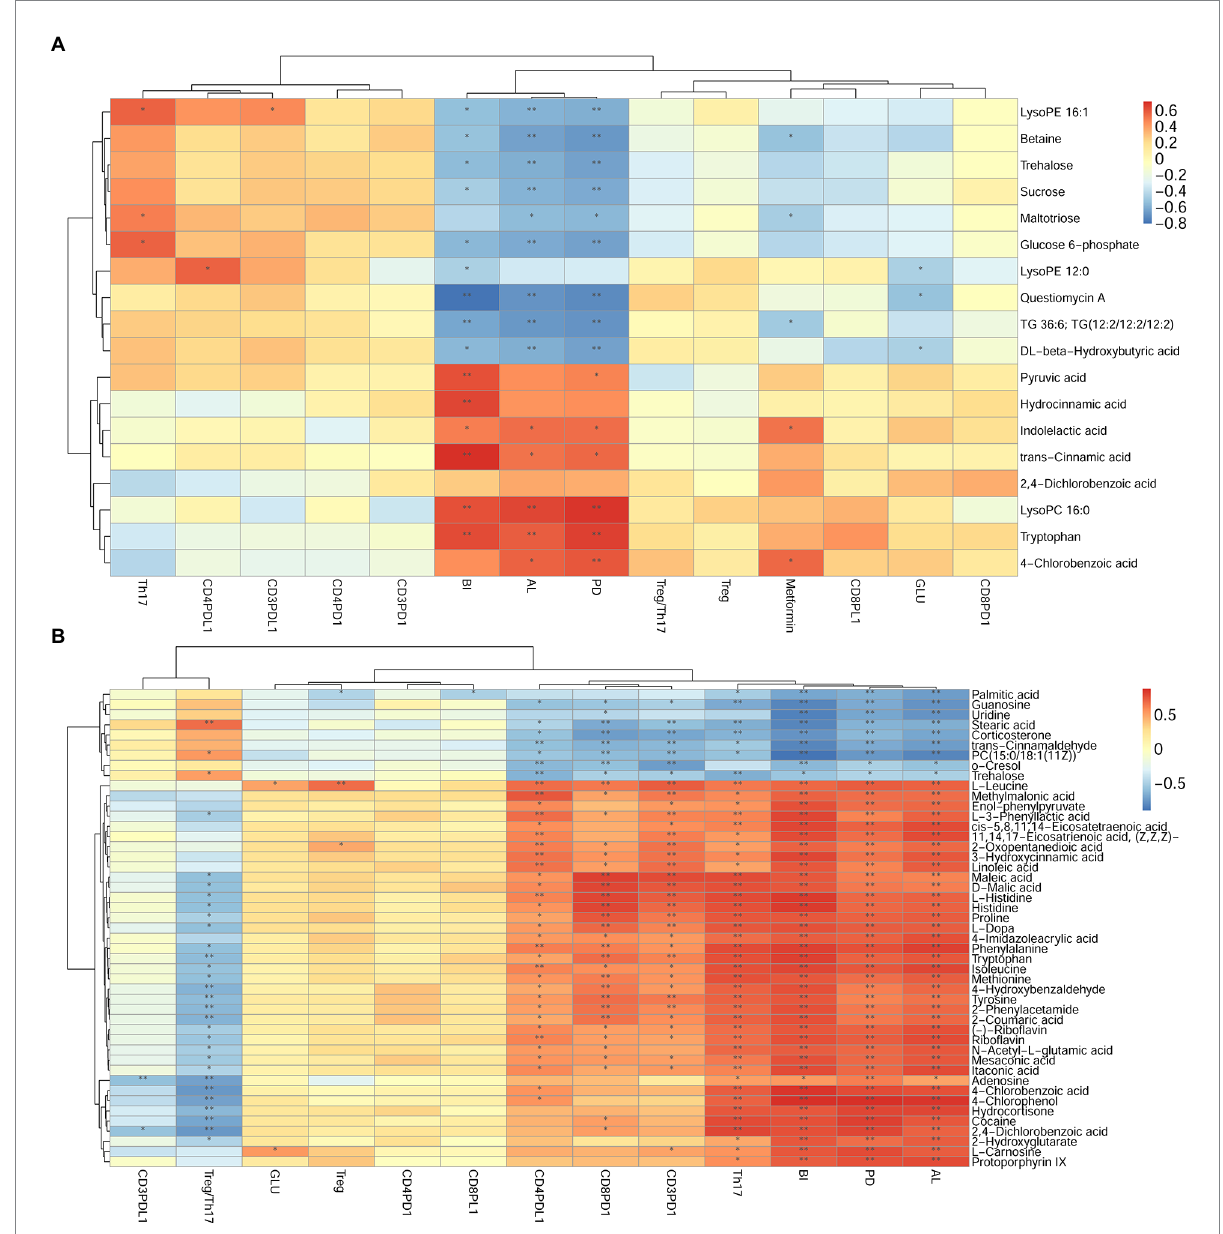
FIGURE 11 Correlation analysis between differential metabolites and clinical index in DP and DNP, P and H, or DP and P groups. (A–B) : Correlation of differential metabolites, clinical index (BI, PD, AL), Th17%, Treg%, Treg/Th17 ratio, and CD4 + /CD8 + PD1/PDL1 expression between (A) , DP and DNP, or (B) , P and H groups. Blue is negative correlation, red is positive correlation (* p < 0.05, ** p <